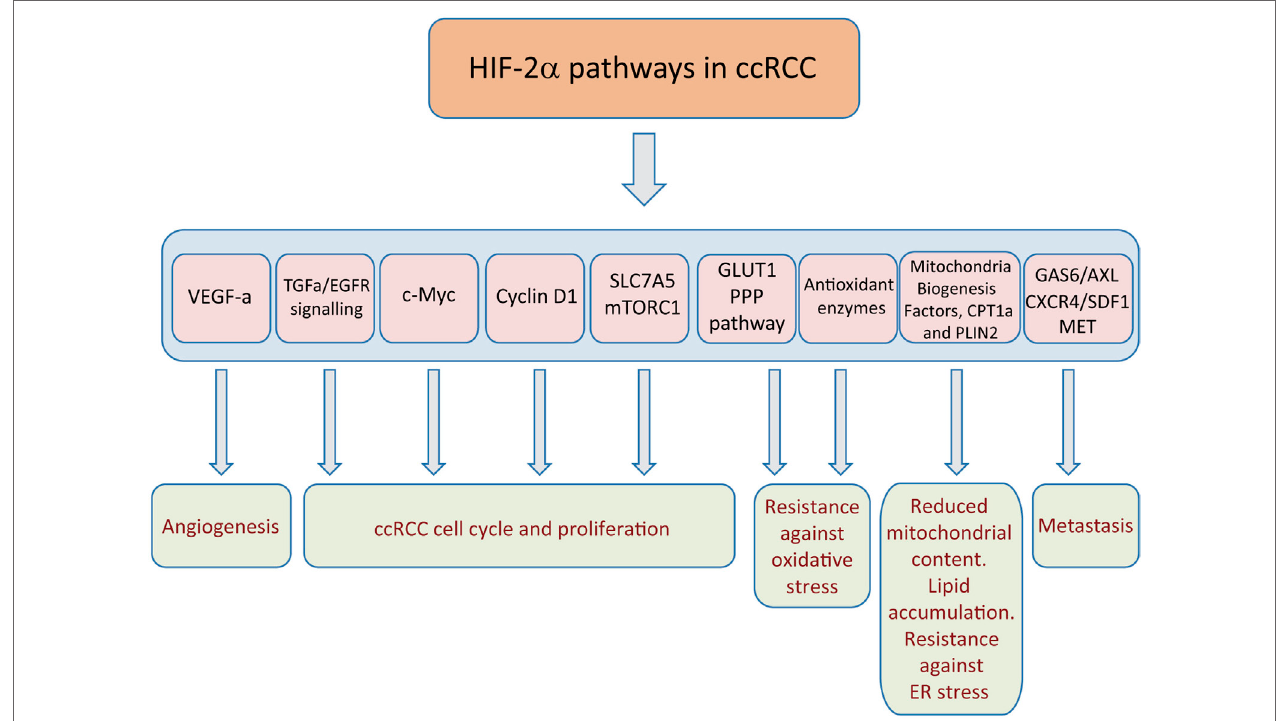
FigURe 2 | Hypoxia-inducible factor (HIF)2 α -dependent pathways that sustain clear cell renal cell carcinoma (ccRCC) growth. The figure represents those target genes primarily controlled by HIF2 α and those biological actions executed by these genes, such as tumor angiogenesis, cell autonomous proliferation, potentiation of glycolysis and pentose phosphate pathway (PPP), resistance to oxidative damage, endoplasmic reticulum (ER) stress, as well as